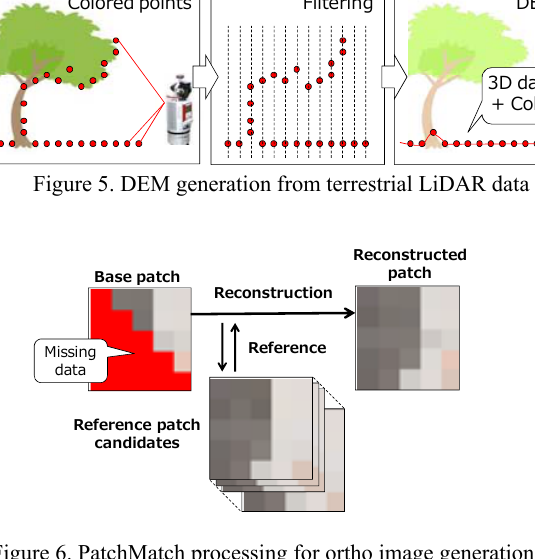
Figure 6. PatchMatch processing for ortho image generation